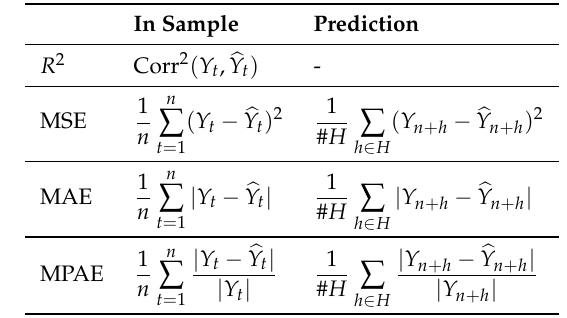
Table 2. Model performance